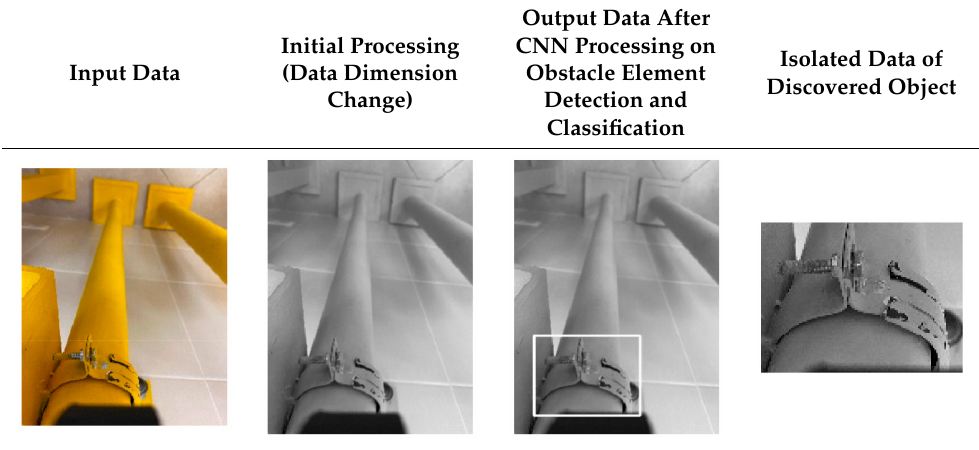
Figure 12a,b illustrates the results of data processing by the neural network for detec- tion of complication signatures on elements of above-ground pipelines affected by coating destruction and/or corrosion. On the left, there are original data before processing by the neural network, on the right there are data after processing in the mode of applying the red contour with shading of the silhouette of discovered